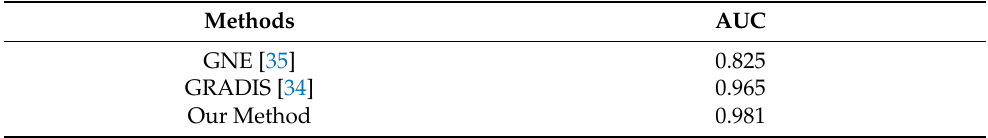
Table 2. Comparative analysis based on the Area Under the ROC Curve